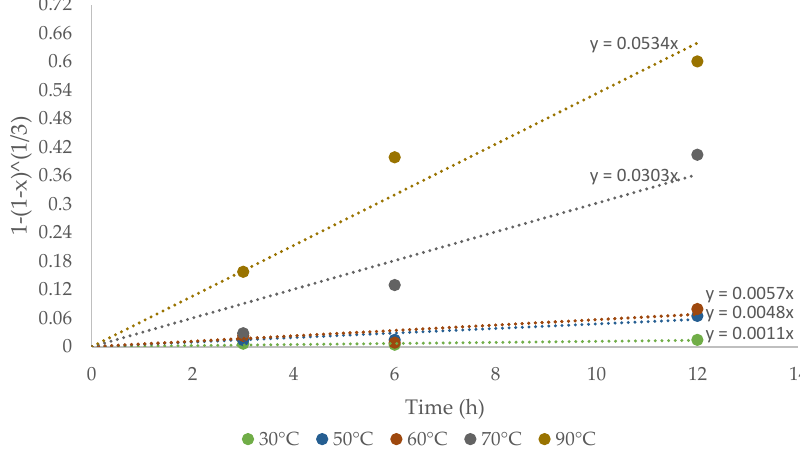
Figure 8. Plot of 1 − (1 − x ) 1/3 versus CuFeS 2 dissolution time.